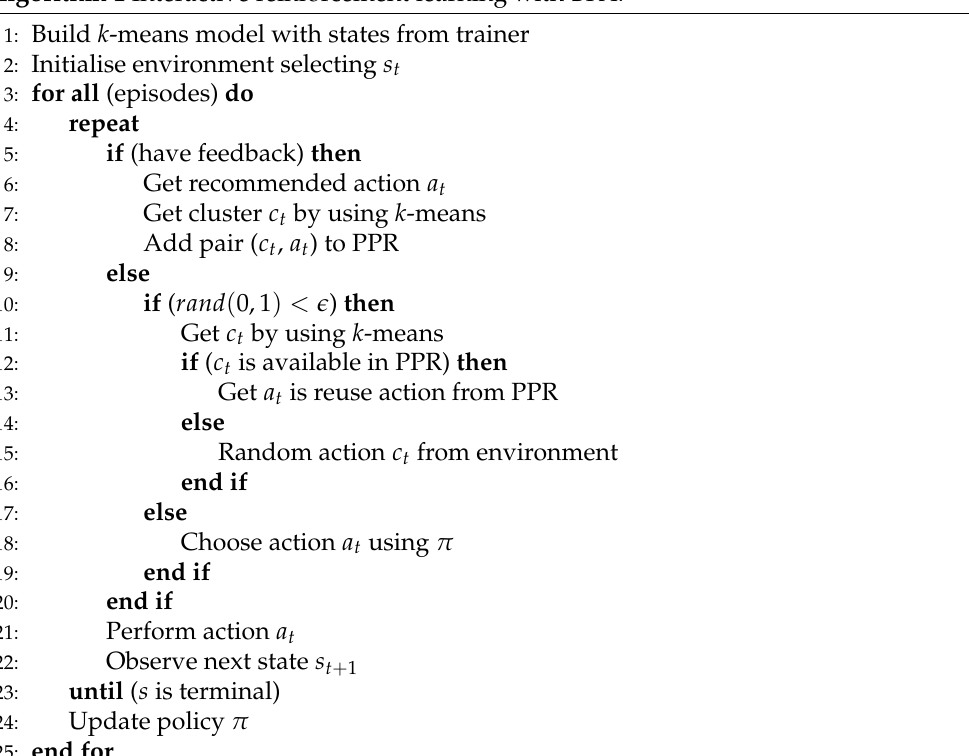
Algorithm 1 Interactive reinforcement learning with